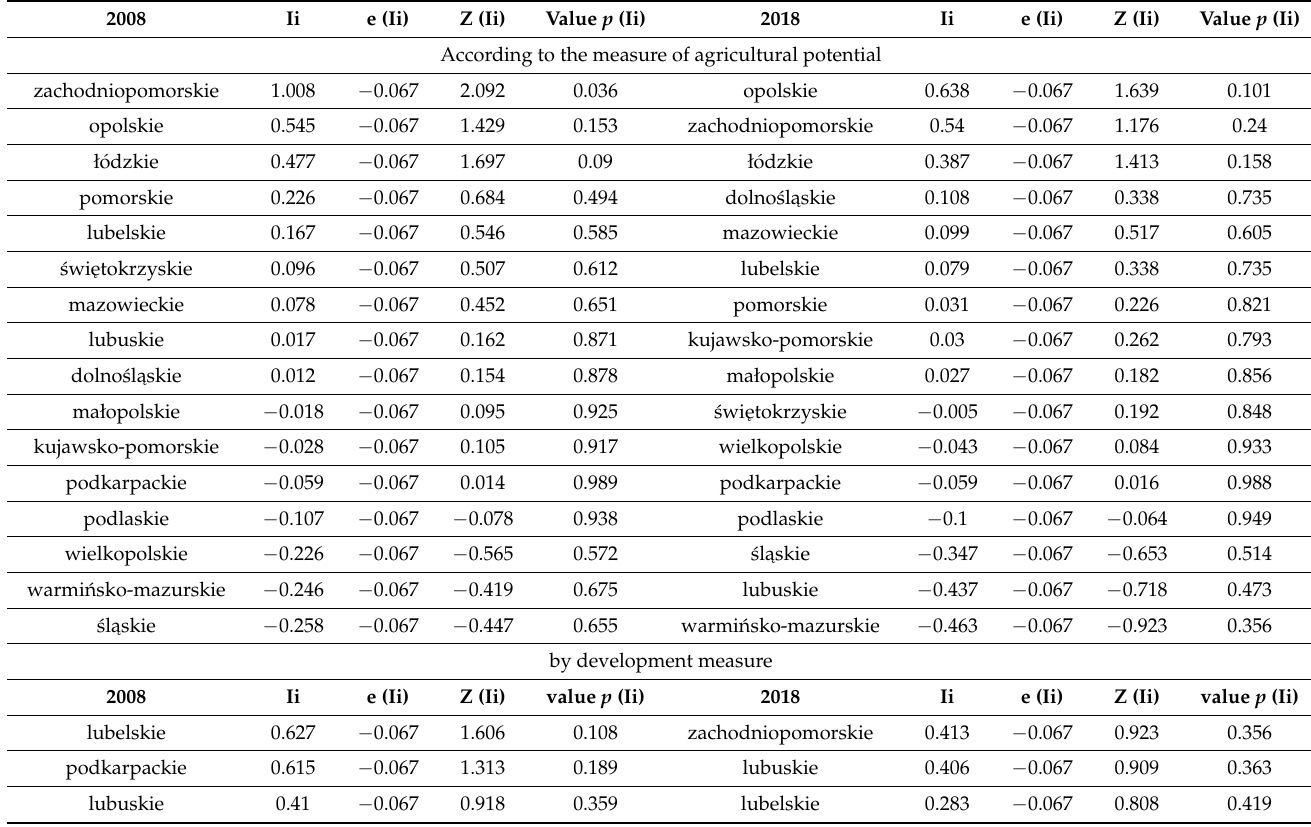
Table 9. Values of local statistics and Moran for the potential of agriculture and development in Poland in terms of voivodships.